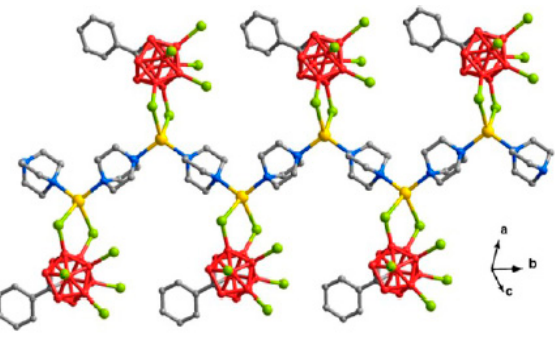
Figure 90. Fragment of X-ray structure of {Ag(DABCO)[1-Ph-1-CB 11 H 5 -7,8,9,10,11,12-I 6 ]} n . Reprinted with permission from reference [77]. Copyright © (2013) American Chemical Society. Complex {(Py) 2 Ag[1-HCB 11 Br 5 I 6 ]·Py} was obtained by recrystallization of Ag[1-HCB 11 Br 5 I 6 ] from pyridine/acetonitrile. The four-coordinated silver atom is in a distorted-tetrahedral arrangement of